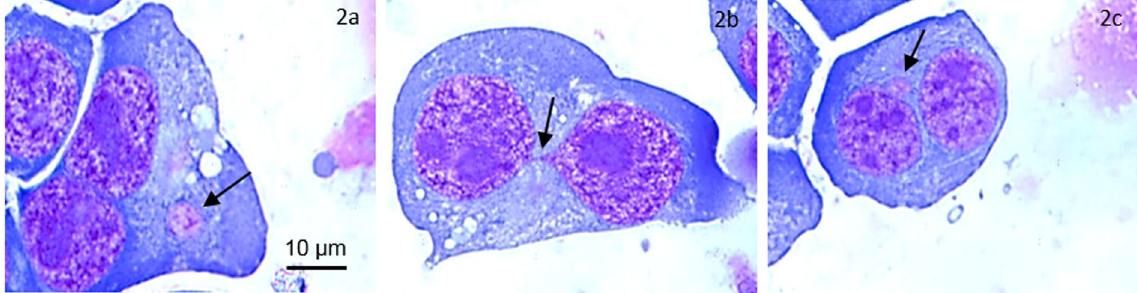
Figure 2. Binucleated WIL2-NS cells following incubation in Ar plasma jet-treated RPMI 1640 with ( a ) a micronucleus (MN), ( b ) a nucleoplasmic bridge (NPB) and ( c ) a nuclear bud (Nbud). Arrows indicate the corresponding biomarkers. Magnification × 1000.